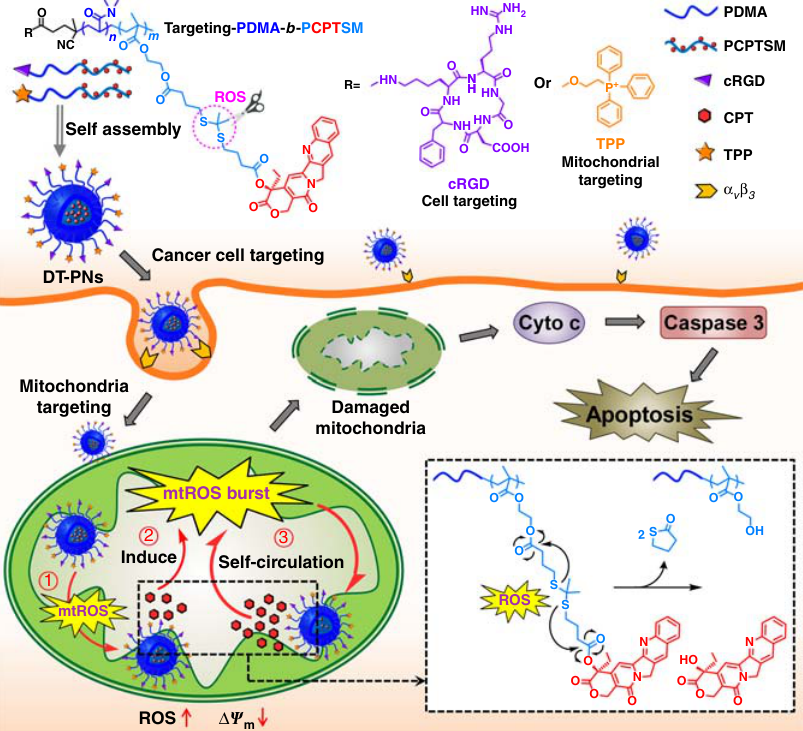
Fig. 1 Mitochondria-speci fi c polyprodrug for self-circulation drug release with ROS burst. Dual-targeting polyprodurg nanoreactors (DT-PNs) were fabricated from the co-assembly of cancer targeting polyprodrug amphiphiles, cRGD-PDMA- b -PCPTSM and mitochondria targeting ones, TPP-PDMA- b - PCPTSM. Upon cellular uptake by cancer cells, DT-PNs can speci fi cally enter mitochondria, then low-level endogenous mitochondrial ROS (mtROS) can induce initial slight CPT release, which stimulates signi fi cant mtROS regeneration, thus further releasing much more CPT. Finally, the self-circulation of CPT Release and ROS burst results in highly oxidative stress, thus initiating mitochondrial dysfunction and cell apoptosis for enhanced cancer chemodynamic